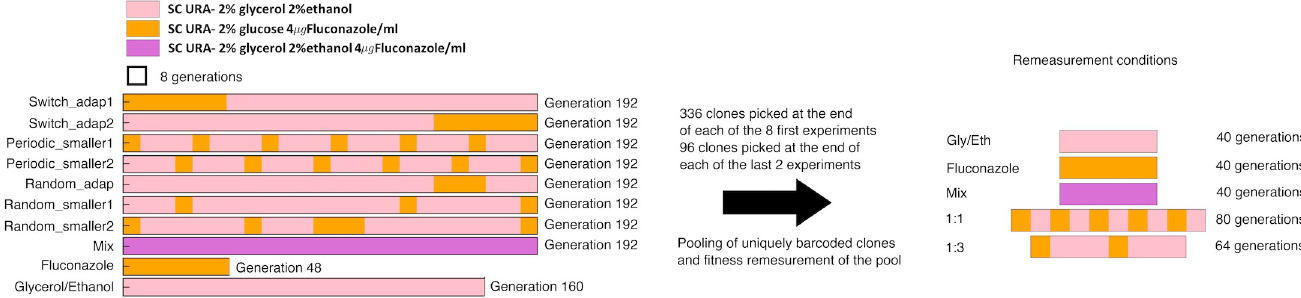
Fig 1. Experimental design. Each experiment with a fluctuating environment was constructed using blocks of 8 generations in Fluconazole and 24 generations in Gly/Eth. At the end of 192 generations, the total time spent in Fluconazole is 48 generations and 144 generation in Gly/Eth, for switch_adap1, switch_adap2, periodic_smaller1, periodic_smaller2 and random_smaller2 experiments. By contrast, in random_adap1 and random_smaller1 the total time spent in Fluconazole is 24 generations, with 168 generations in Gly/Eth. Two additional experiments, which did not switch between environments, were also carried out. Clones isolated from each experiment were pooled, and then had their fitness remeasured under 5 different conditions (right).